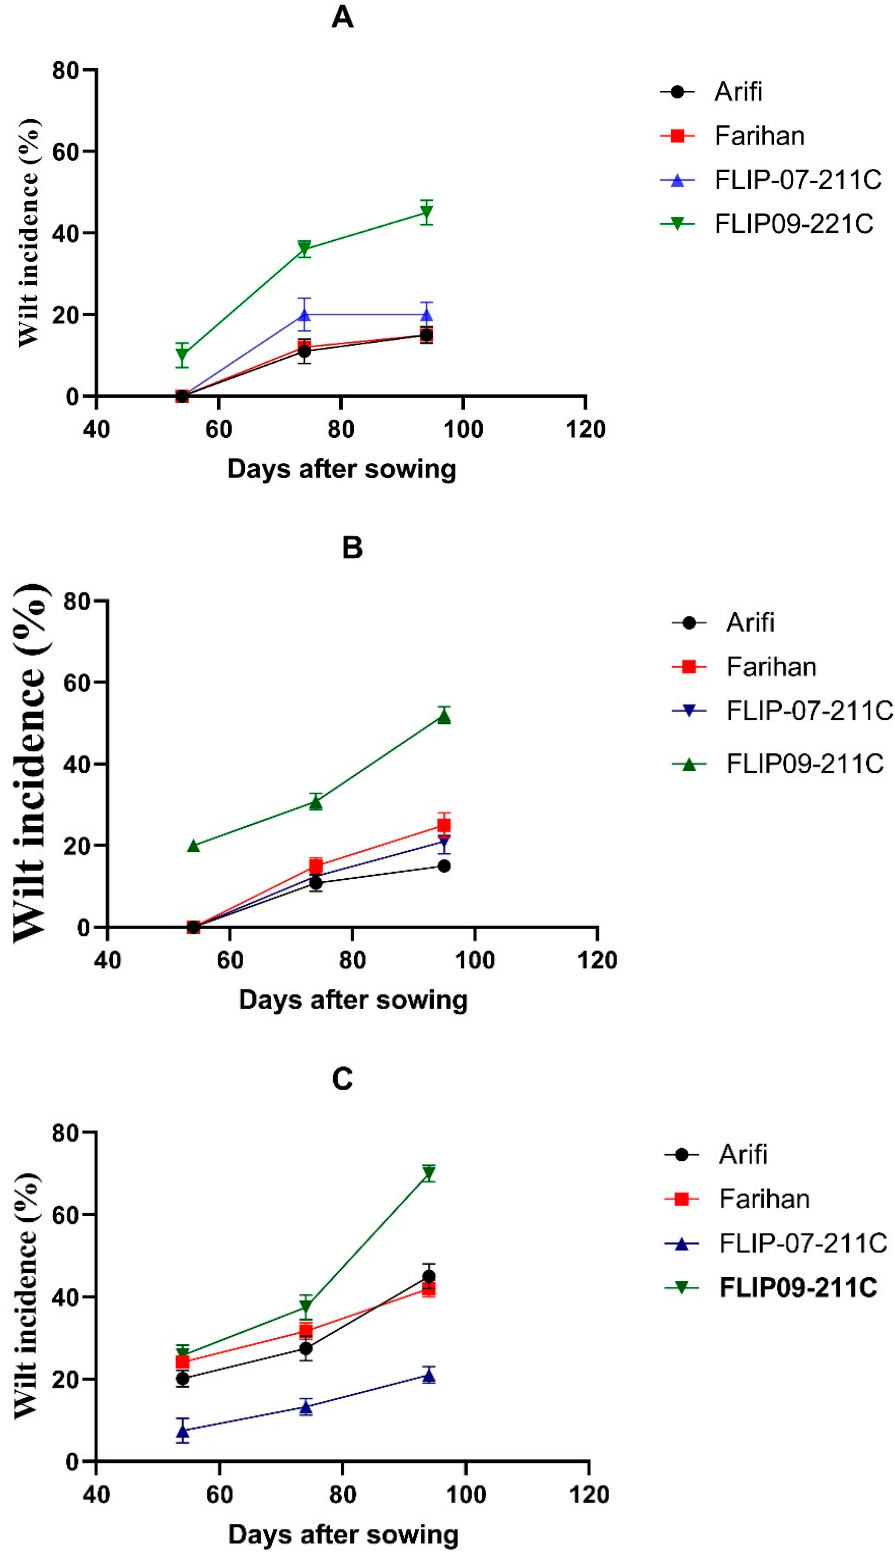
Figure 2. Disease progress wilt on the four chickpea genotypes as affected by sowing dates ( A ) mid- December, ( B ) mid-January, and ( C ) mid-February. The vertical bars represent standard deviation with three replicates.